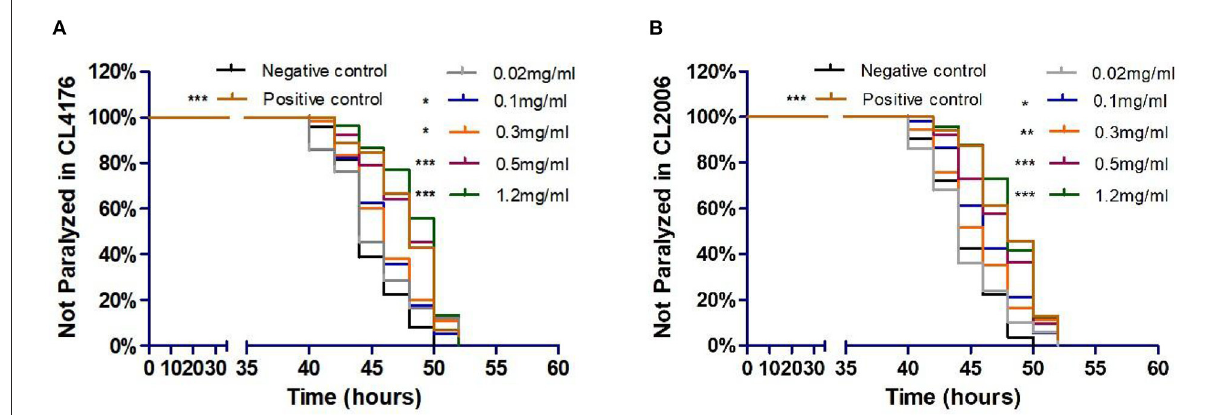
FIGURE2 Exendin-4 alleviated A β -induced paralysis in transgenic C. elegans strains CL4176 and CL2006. (A) In CL4176. (B) In CL2006. Curves show the process of A β -induced paralysis in transgenic C. elegans treated with a vehicle control (H 2 O) or different concentrations of Exendin-4 (0.02 mg/ml, 0.1 mg/ml, 0.3 mg/ml, 0.5 mg/ml, and 1.2 mg/ml). Caffeine (1.2 mg/ml) is positive control. The onset of paralysis was prolonged in CL4176 and CL2006 worms in a dose-dependent manner (at least 40 worms were tested in each group, and the experiments were repeated independently for three times).